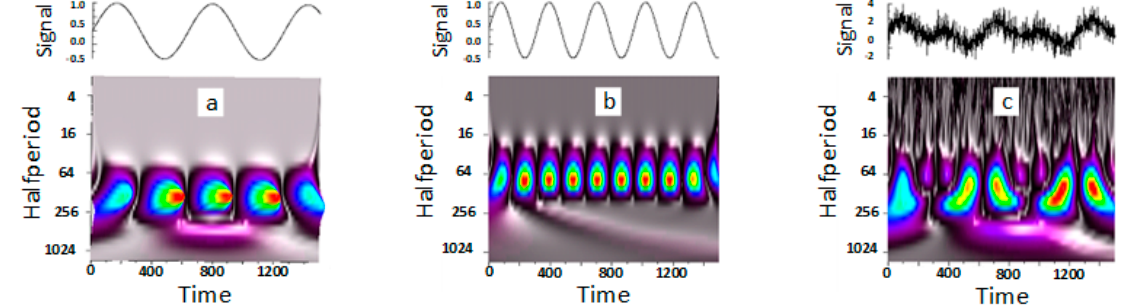
Figure 1. Examples of wavelet-periodograms with obvious periodicity in data distribution: ( a )—the signal in the form of a sinusoid and the result of its wavelet transformation using a Gaussian wavelet; ( b )—result when the frequency of the sinusoid is twice as high; ( c )—the signal is the sum of two previous sinusoids with the adding of Gaussian noise.